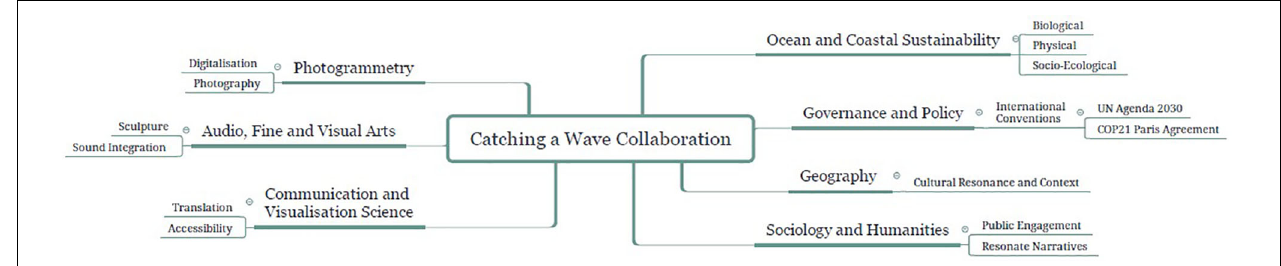
FIGURE 2 | The architecture for a transdisciplinary collaboration for shared knowledge generation elements that underpins CaW to reflect both cognitive and emotional elements that can support societal transformation for sustainability. The collaboration acts as an integrating interface between both disciplines of enquiry and communication technologies to develop products – in this case artistic representations of waves- to encourage and enable conversations between holders of different facets of knowledge, opinions and perspectives that might not otherwise take place, or would take place in a contested